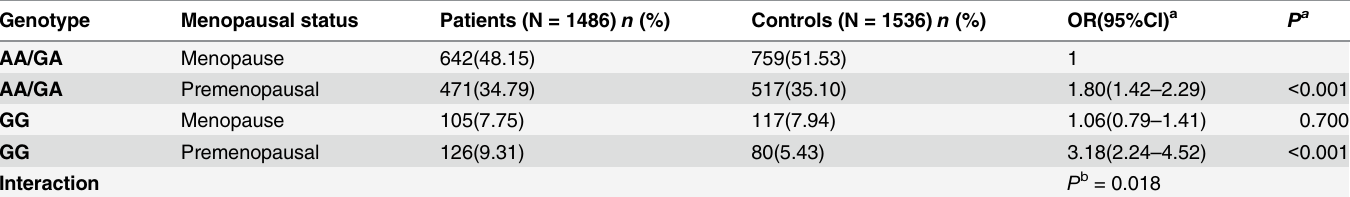
Table 7. Crossover analysis in genotypes-menopausal status interaction study on cervical cancer.